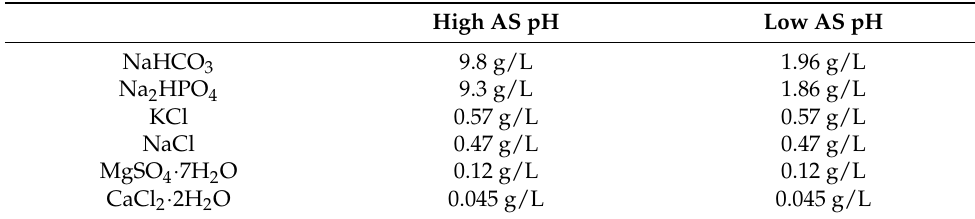
Table 1. The composition of the buffer.